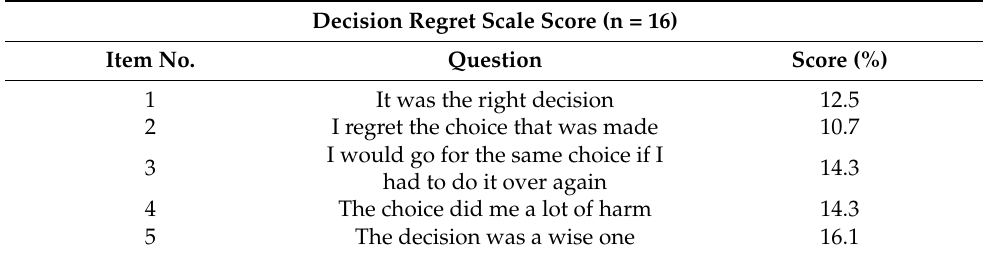
Table 3. DRS score for delayed surgery group. Score > 50 indicates decision